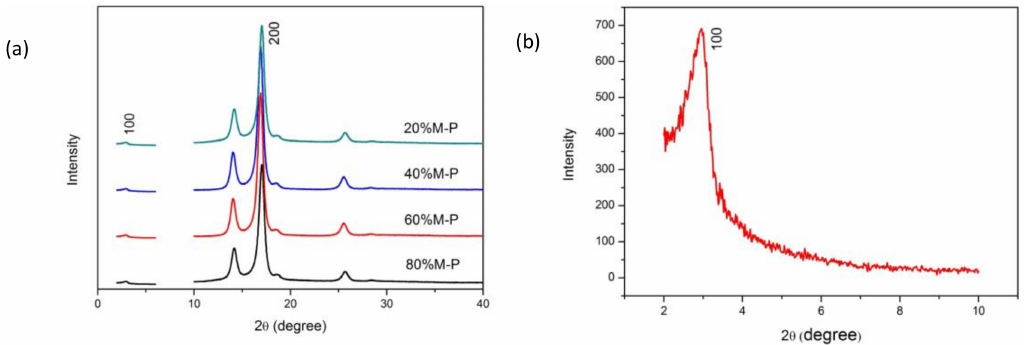
Figure 5. XRD patterns of ( a ) honeycomb composite fibers and ( b ) OPM.